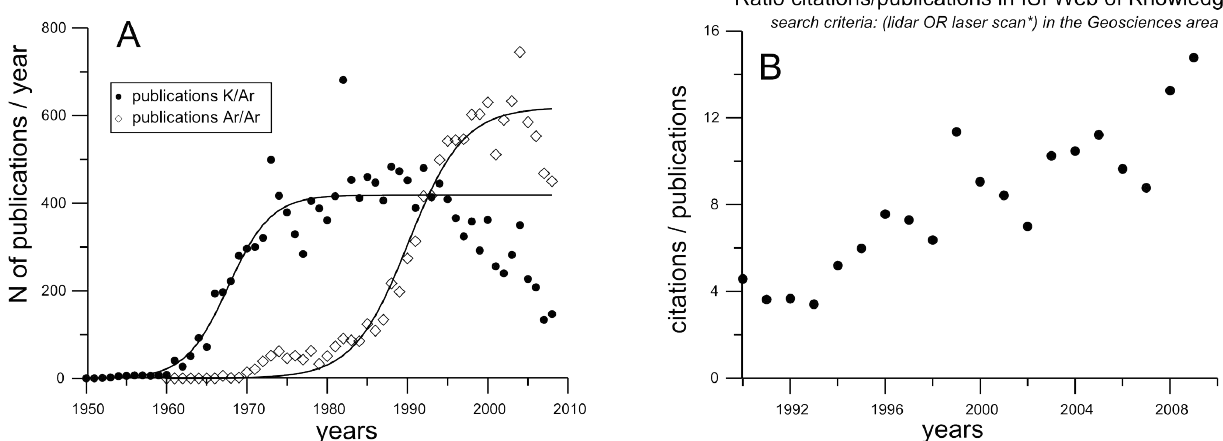
Fig. 2. (A) Number of publications registered in GEOREF per year for the thermochronological techniques K/Ar and Ar/Ar , and associated best fit logistic functions ( K =418 and r =0.38 for K/Ar , K =619 and r =0.29 for Ar/Ar ). (B) Ratio of the number of citation to the number of publication per year (from ISI Web of knowledge), related to LIDAR or laser scanning in the subject area of